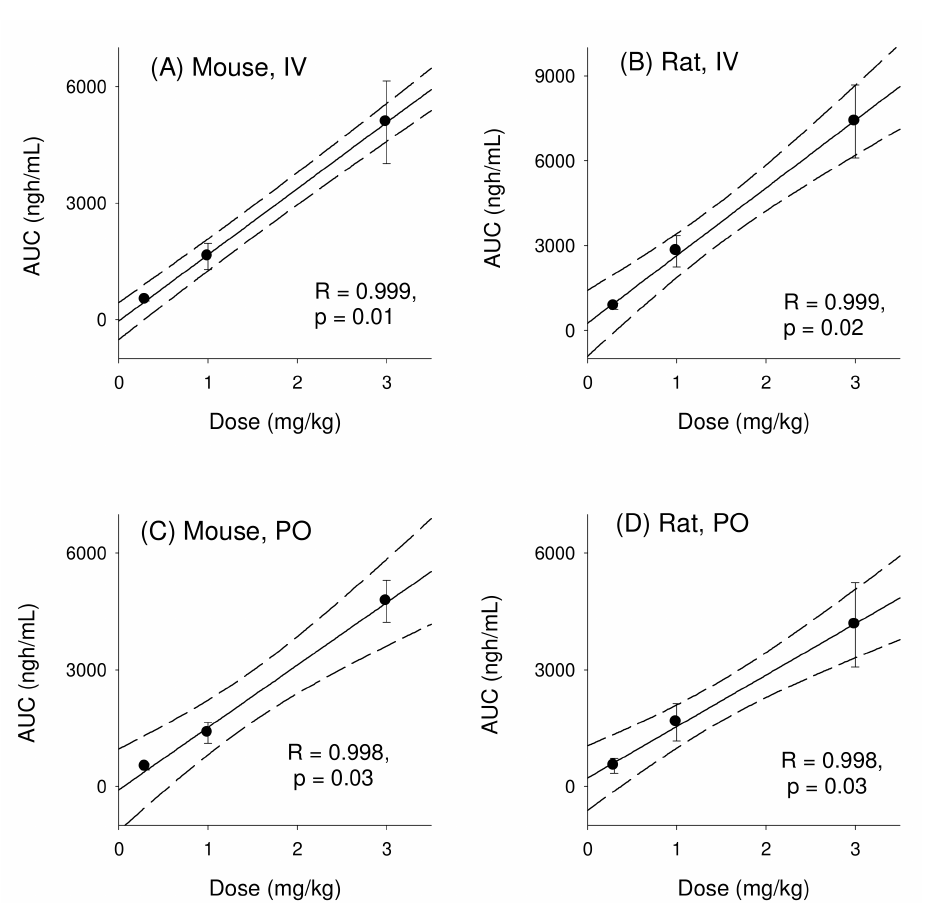
Figure 4. Correlations between AUC or C 0 values for enavogliflozin and intravenous doses of enavogliflozin in ( A ) mice and ( B ) rats. Correlations between AUC or C max values for enavogliflozin and oral doses of enavogliflozin in ( C ) mice and ( D ) rats. Lines were generated from linear regression analysis and 90% confidence intervals around the geometric mean value. R represents the correlation coefficient and p represents the statistical significance for the regression analysis. Data represent mean ± standard deviation (n = 4 per dose for IV, n = 6 per dose for